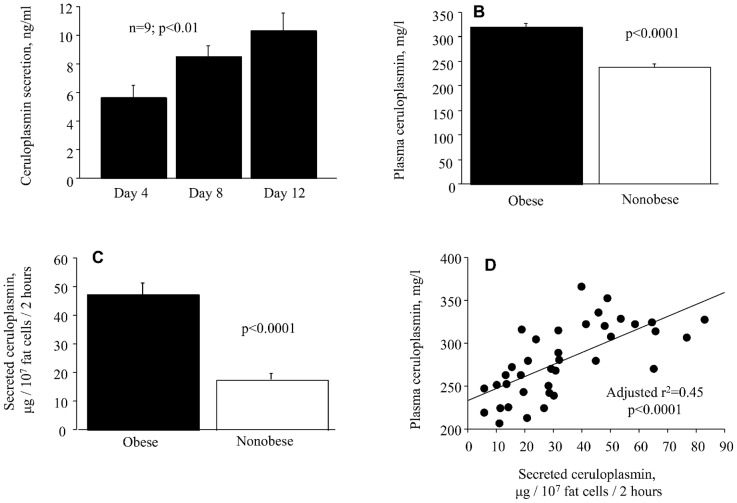
Secretion of ceruloplasmin from fat cells.A. Secretion during differentiation of progenitor cells to fat cells. Data are analysed by ANOVA, repeated measures. B and C. Influence of obesity on plasma levels and secretion from adipose tissue as analyzed with unpaired t-test. D. Relationship between secreted ceruloplasmin and its plasma levels as analyzed with linear regression.